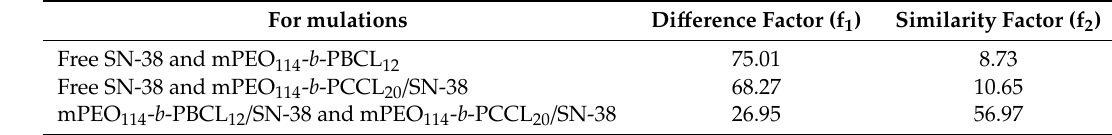
Table 2. Calculated di ff erence factor (f 1 ) and similarity factor (f 2 ) for SN-38 release profiles